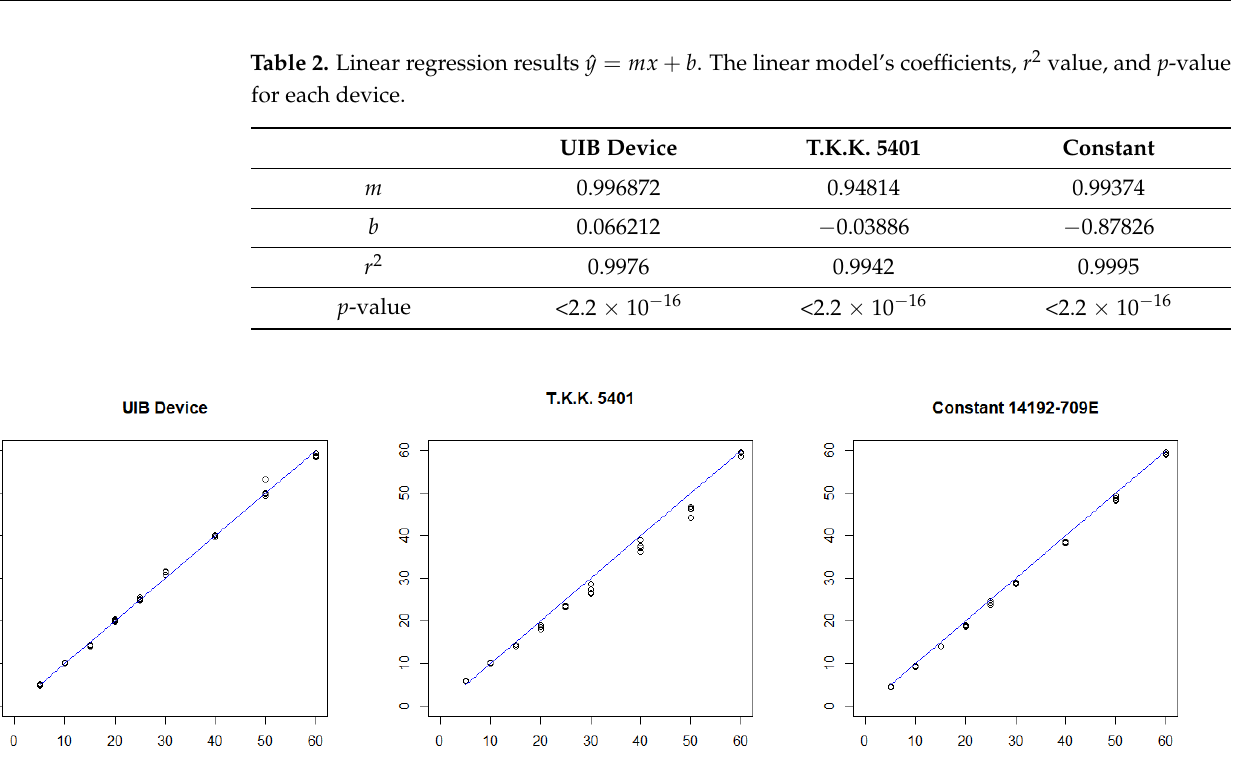
Table 1. Measurement table with calibration load and display dynamometer value.